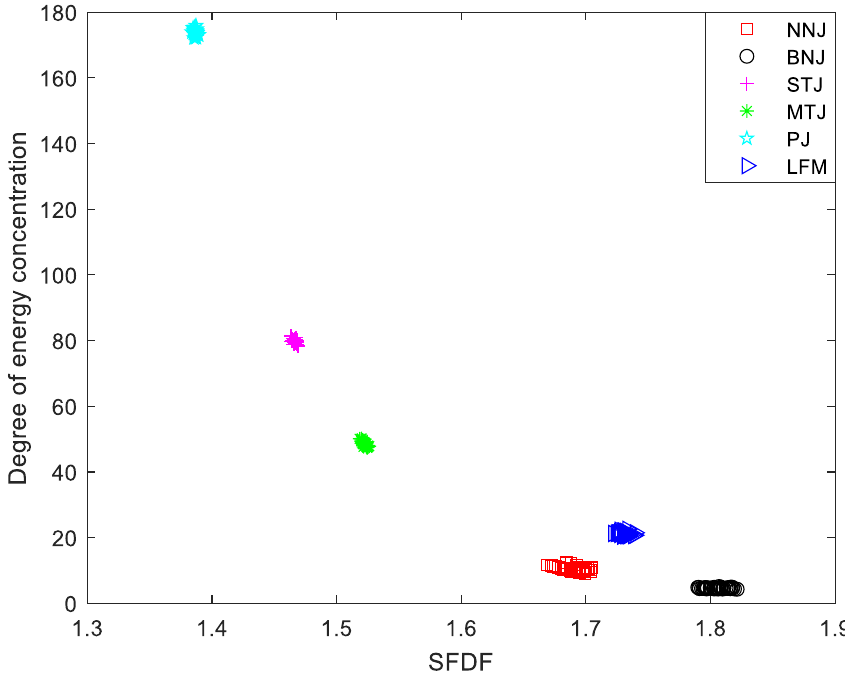
Figure 4. Characteristic distribution diagram of six types of jamming.